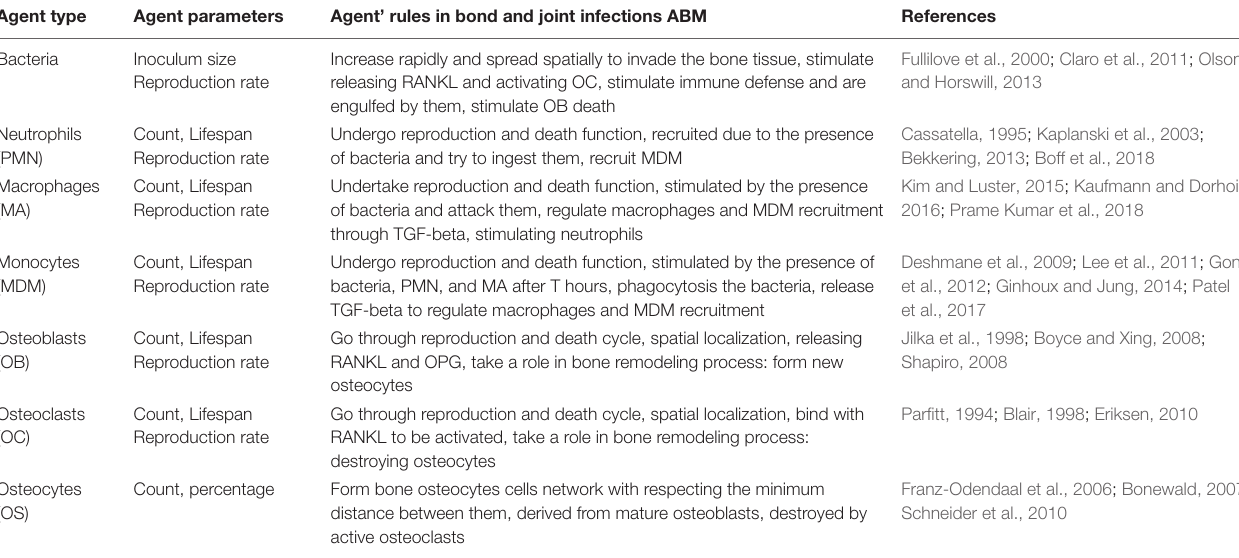
TABLE 1 | List of the agents in the bone and joint infections agent-based model, their rules, and behaviors. Agent type